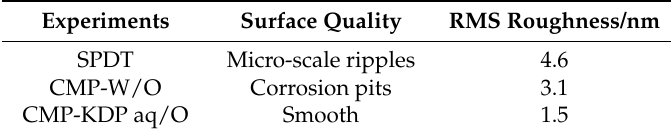
Figure 5. Surface microstructures of different KDP samples: ( a ) KDP after SPDT; ( b ) KDP after CMP with traditional W/O microemulsion; and ( c ) KDP after CMP with KDP aq/O microemulsion ( c KDP was 30 mM). Table 1. RMS roughness for KDP crystal after experiments of SPDT, CMP-1 and CMP-2 (polishing condition: temperature 20 C, humidity 40% RH, pressure 5 kPa).